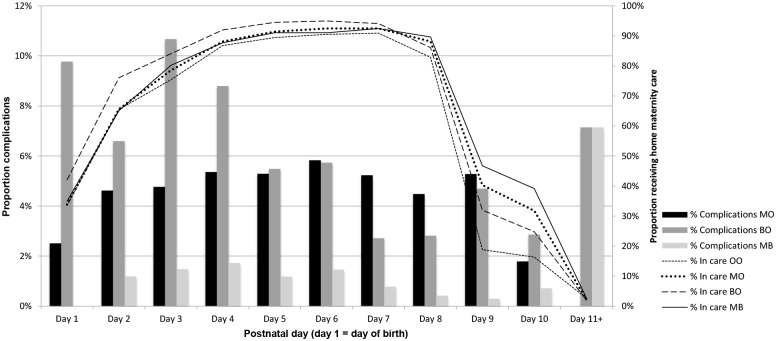
Daily postnatal complications rate (bars) and proportion of mother-baby pairs receiving home maternity care (lines) by postnatal day.